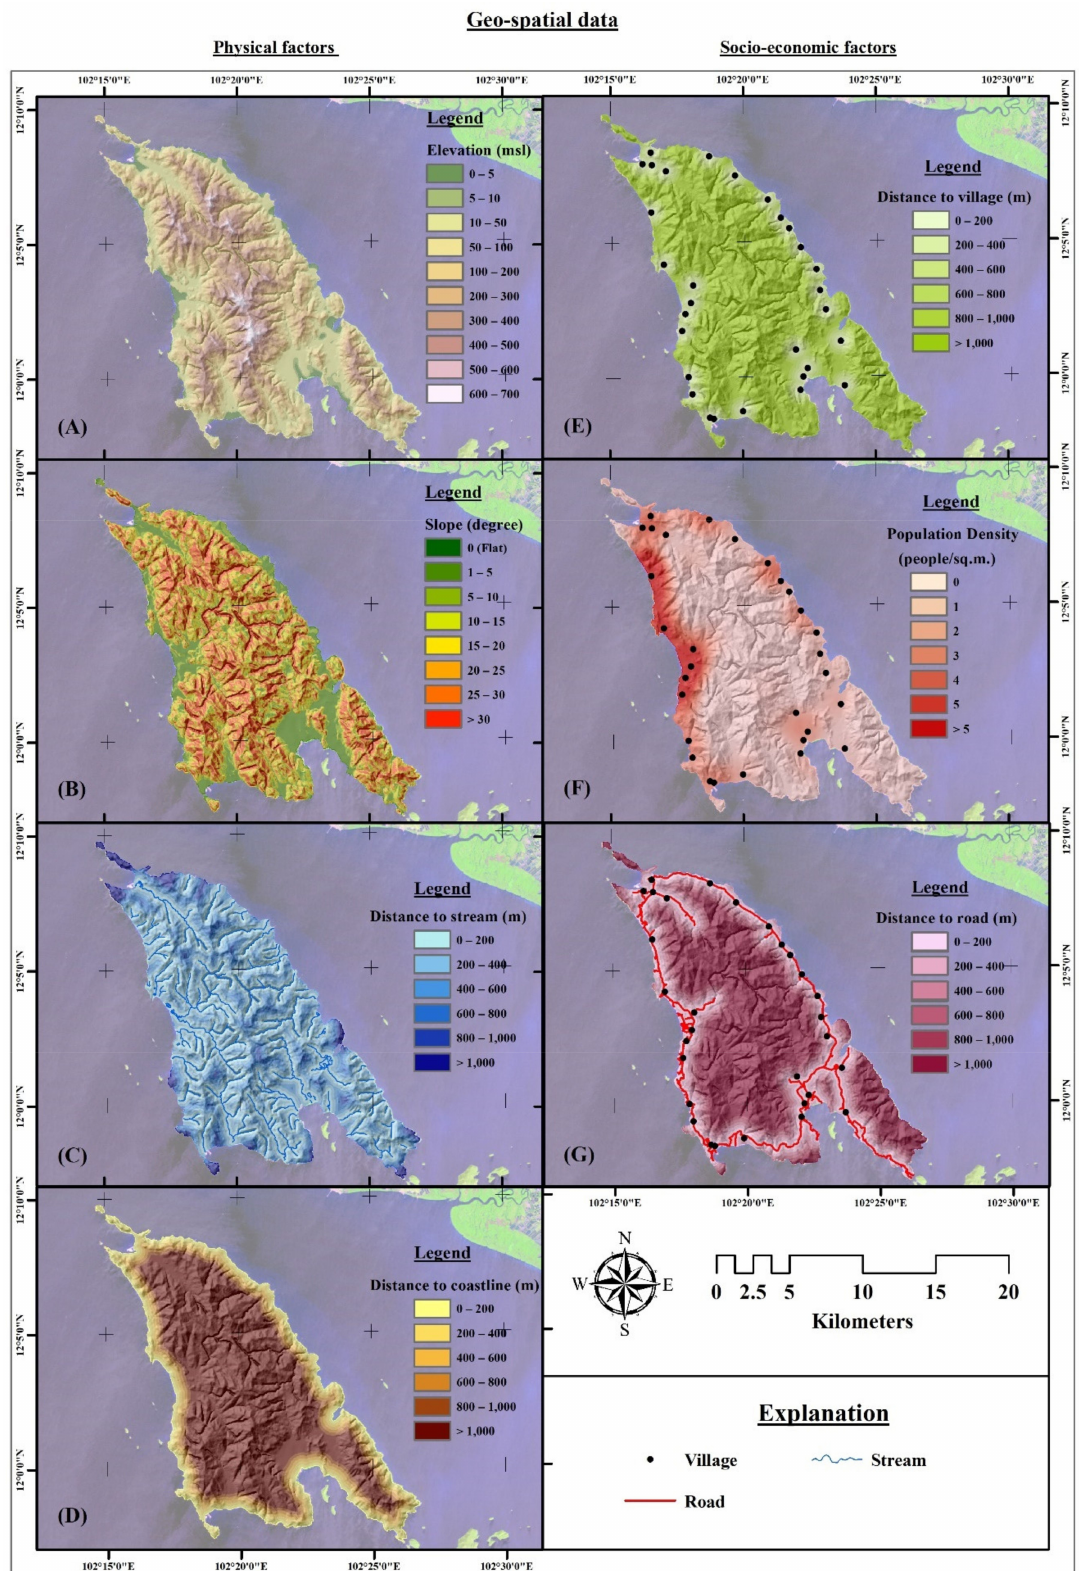
Figure 2. Geo-spatial data (physical factors and socio-economic factors) in the Koh Chang area. ( A ) elevation, ( B ) slope, ( C ) distance to stream, ( D ) distance to coastline, ( E ) distance to village, ( F ) population density, and ( G ) distance to